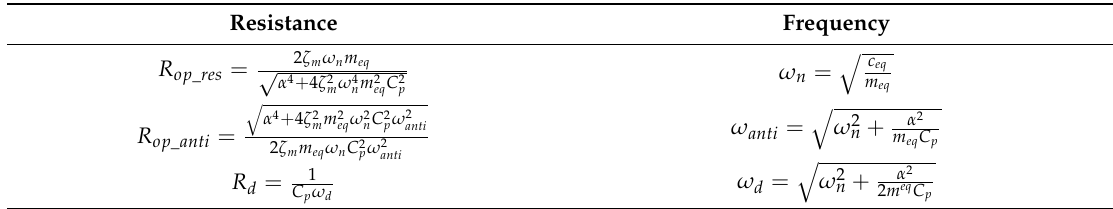
Table 5. Significant applied load resistances and corresponding frequencies for maximum power.